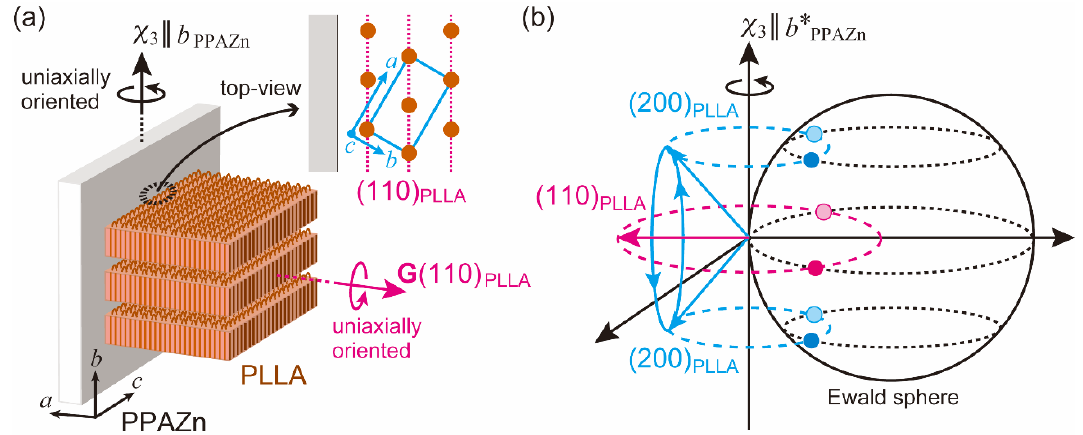
Figure 11. Schematic diagrams explaining the diffraction patterns obtained for PPAZn/PLLA-8TR. ( a ) The PLLA lamellae grew from the surface of PPAZn with the c -axis (chain axis) of PLLA parallel to the bc -plane of PPAZn. The stacked lamellae were uniaxially oriented along the direction of the reciprocal vector, G (110) PLLA . In addition, the PPAZn substrate uniaxially aligned along the χ 3 -axis ( (cid:107) b -axis) under a rotating magnetic field. ( b ) Under this condition, the G (200) PLLA vectors were randomly distributed along the G (110) PLLA oriented uniaxially along the χ 3 -axis ( (cid:107) b *-axis) of the substrate, resulting in two diffraction spots of (110) PLLA on the equator, and four diffraction spots of (200) PLLA at positions shifted by approximately 60° from the (110) PLLA diffraction spots.